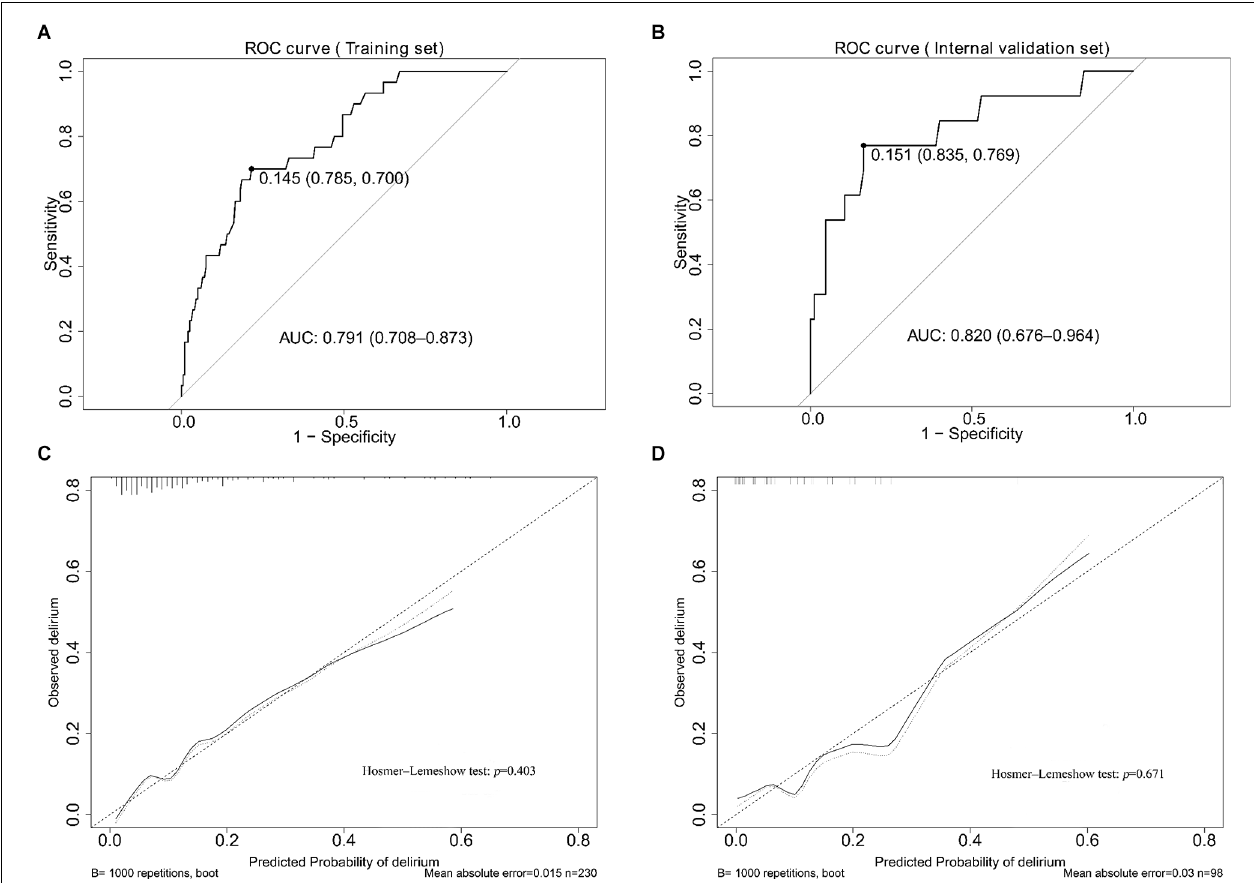
FIGURE 3 | The results of the ROC curve and calibration analysis of the nomogram in the training set and the internal validation set. (A,B) The AUC and the calibration curve of the nomogram for predicting POD in the training set. (C,D) The AUC and the calibration curve of the nomogram for predicting POD in the internal validation set.